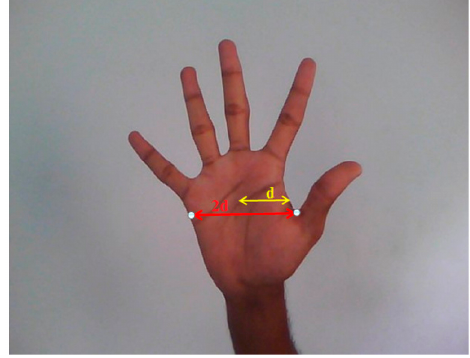
Figure 9. Image of the hand width.